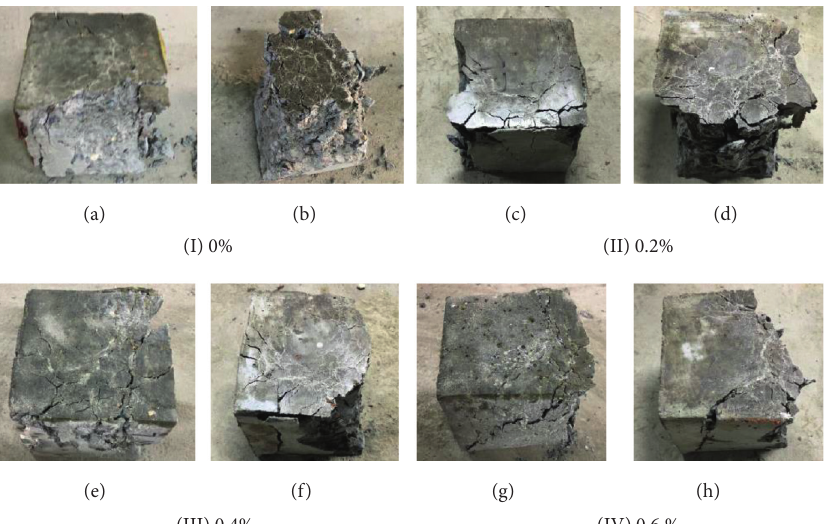
Figure 3: Compressive failure modes of polypropylene fiber reinforced concrete under different loading conditions. (a) 1 × 10 − 5 /s. (b) 5 × 10 − 3 /s. (c) 1 × 10 − 5 /s. (d) 5 × 10 − 3 /s. (e) 1 × 10 − 5 /s. (f) 5 × 10 − 3 /s. (g) 1 × 10 − 5 /s. (h) 5 × 10 − 3